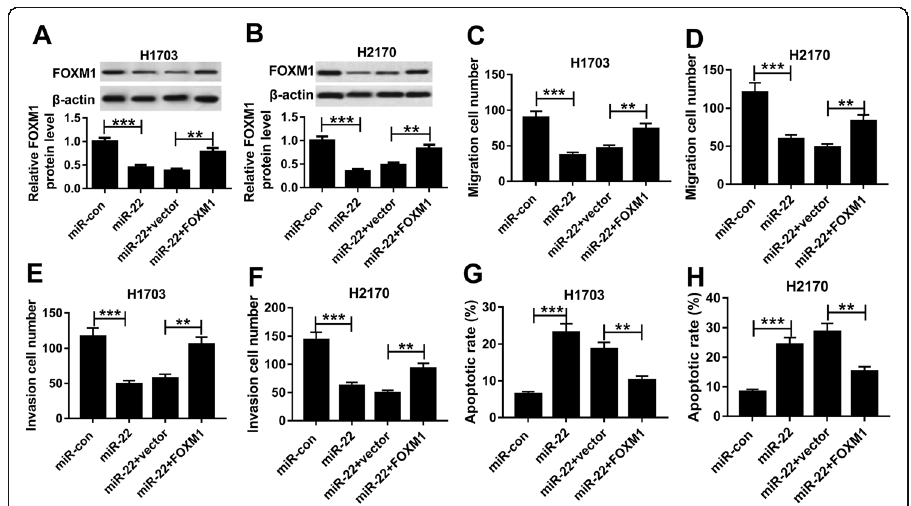
Fig. 5 Overexpression of miR-22 inhibits cell carcinogenesis in LUSC by targeting FOXM1. H1703 and H2170 cells were transfected with miR-con, miR-22, miR-22 + vector, or miR-22 + FOXM1. a , b Western blot was used to detect the level of FOXM1 in H1703 and H2170 cells. c - f Migrated and invaded cells were detected by transwell assay. g , h Apoptotic cells were measured using flow cytometry. * P < 0.05, ** P < 0.01, *** P <